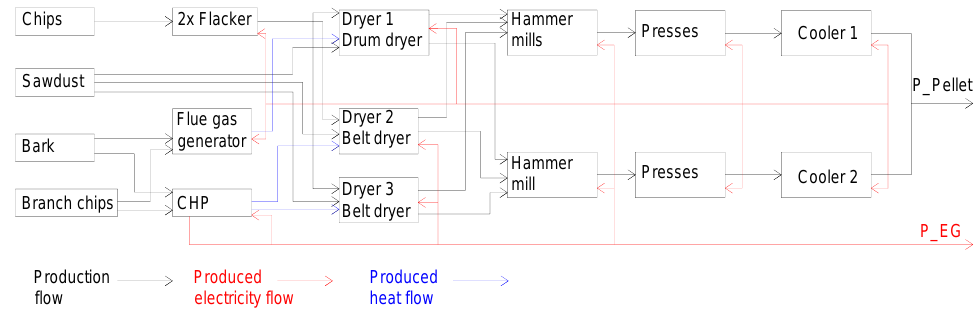
Fig. 2. Initial operational scheme of the pellet production facility [3].